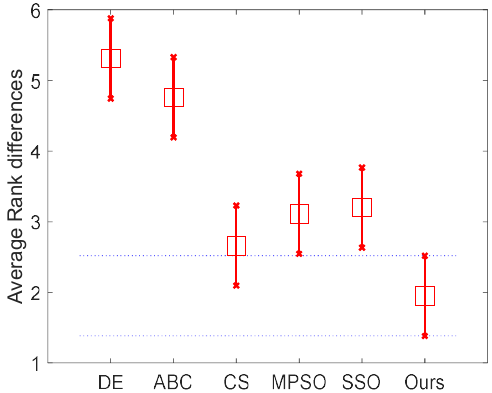
Figure 7. Friedman test of the normal level.